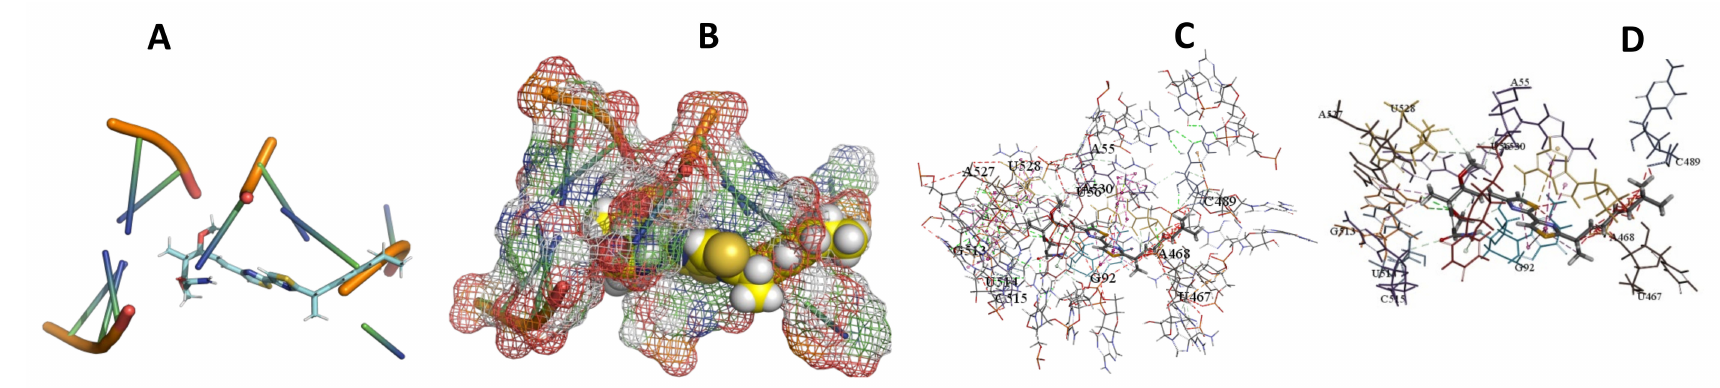
Figure 25. T. Brucei + Myxothiazol. ( A ): Best binding pose and nucleotides involved. ( B ): Schematic binding pocket. ( C ): shows the Nucleotides component that re involved in binding. ( D ): Shows the main bonds involved between the compound and the nucleotide